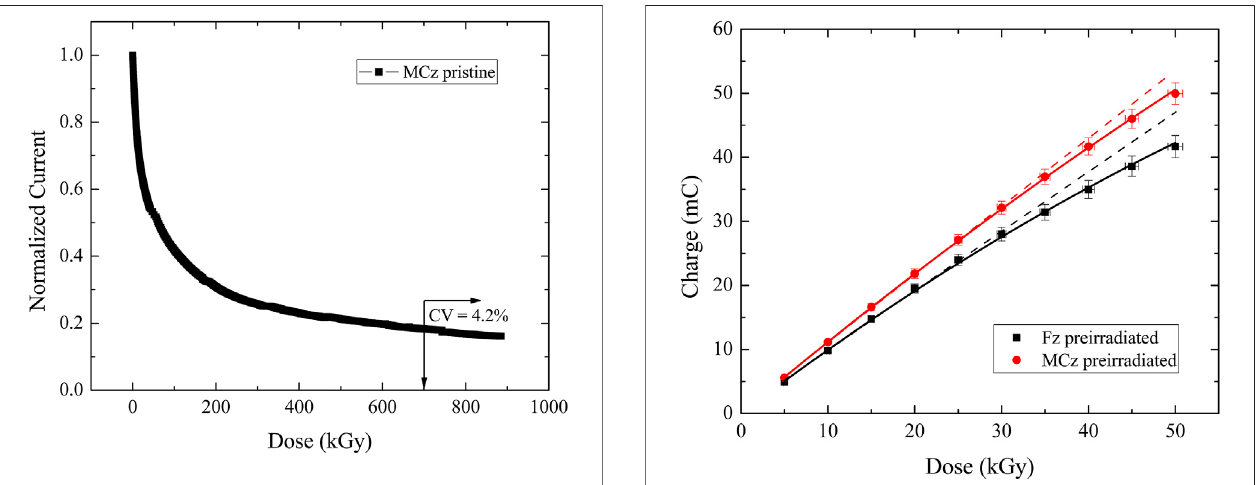
FIGURE6| DecreaseintheinducedcurrentsdeliveredbyapristineMCz diode over 900 kGy related to the maximum values at the beginning of irradiation. For doses higher than 700 kGy, the coef fi cient of variation (CV) of the current signals is 4.2%.